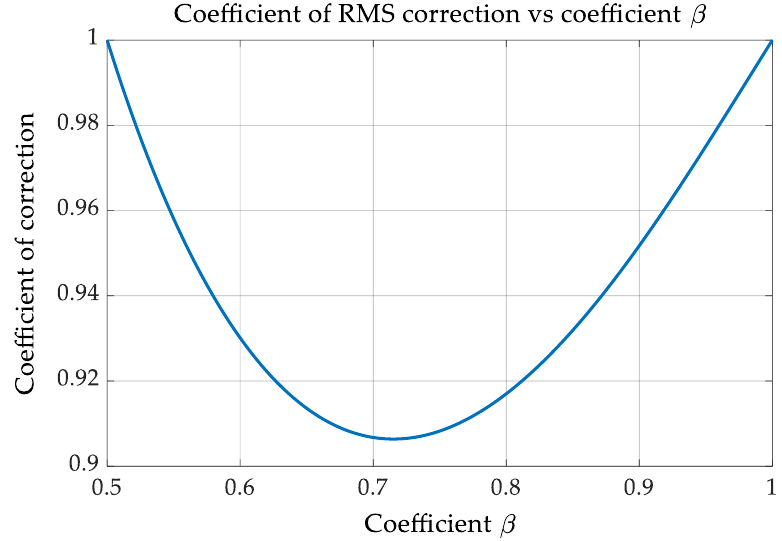
Figure 2. Coefficient of correction RMS estimation through the fraction of AC period.